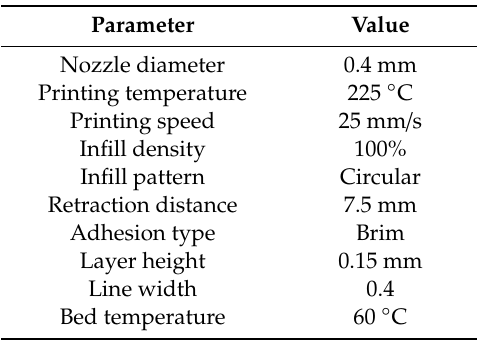
Table 1. Parameters for the embedded air connector (EAC).